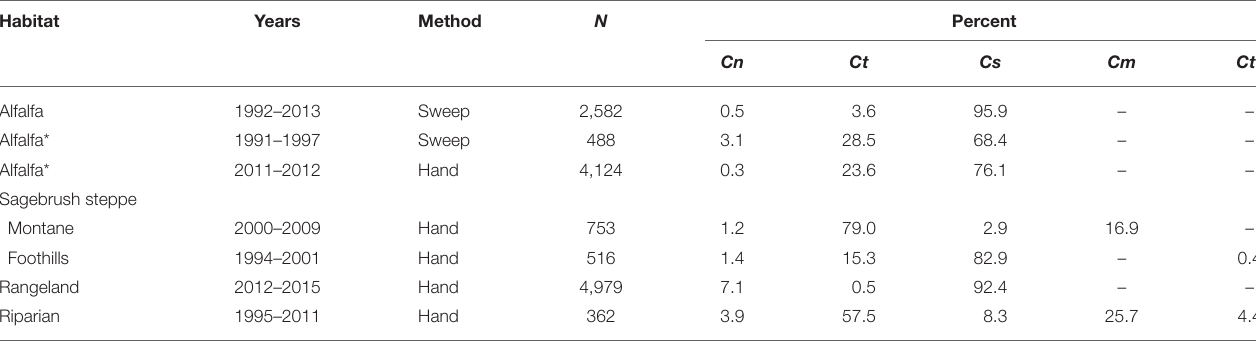
TABLE 3 | The percentage of lady beetle adults belonging to Coccinella spp. represented by C. novemnotata ( Cn ), C. transversoguttuta ( Ct ), C. septempunctata ( Cs ), C. monticola ( Cm ), and C. trifasciata ( Ctf ), as collected in different habitats. Habitat